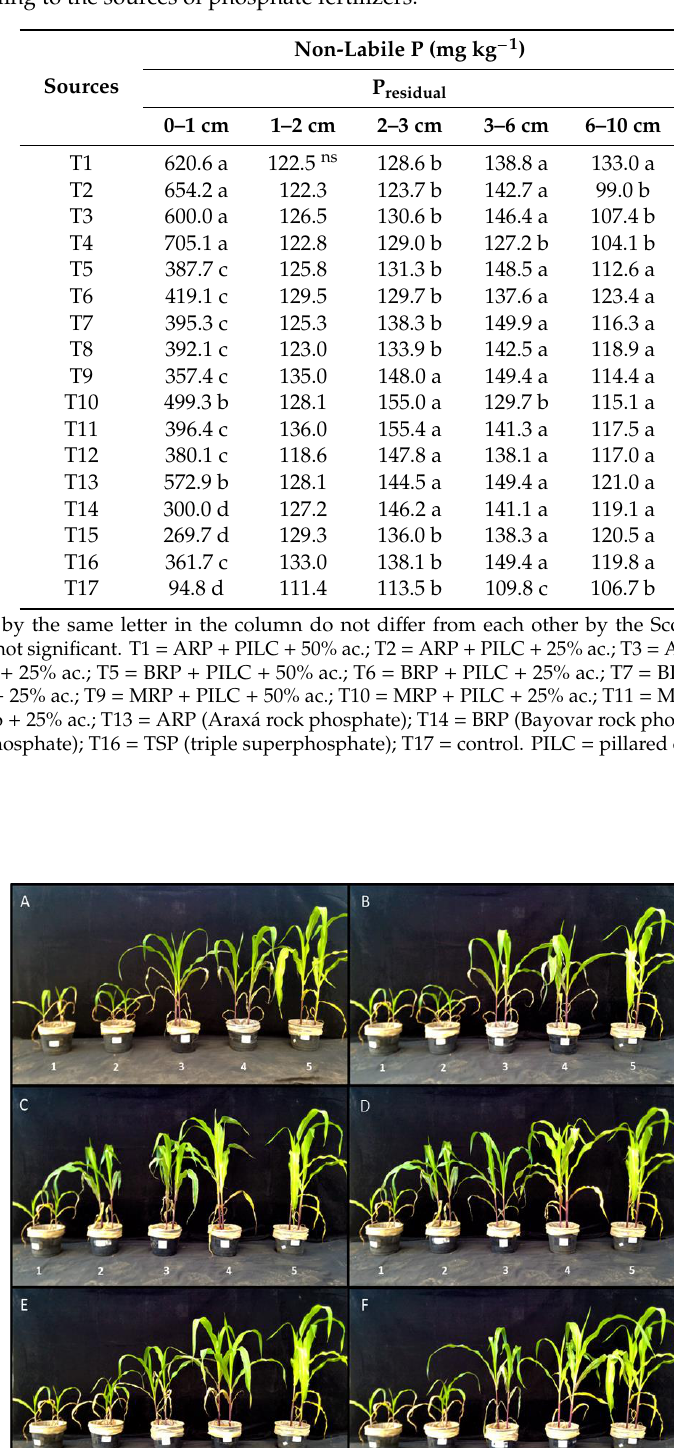
Table A4. Residual fraction (P residual ) of P in the soil, considered non-labile, in di ff erent layers of the columns according to the sources of phosphate fertilizers.